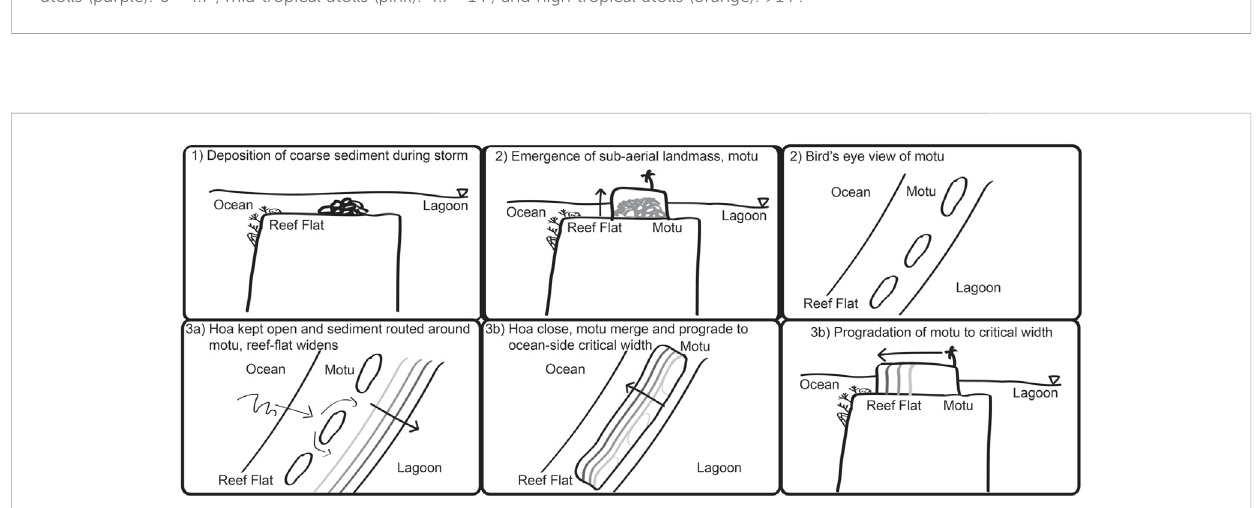
FIGURE 13 Conceptualmodelofmotuformationandevolutiononthereef fl atadaptedfromOrtizandAshton(2019)frominitialmotucreationandemergence (1 – 2) to divergence of motu evolution leading to widening of the underlying reef- fl at (3a) or narrowing of the motu to ocean side reef fl at (ocean reef width) with elongated motu (3b)